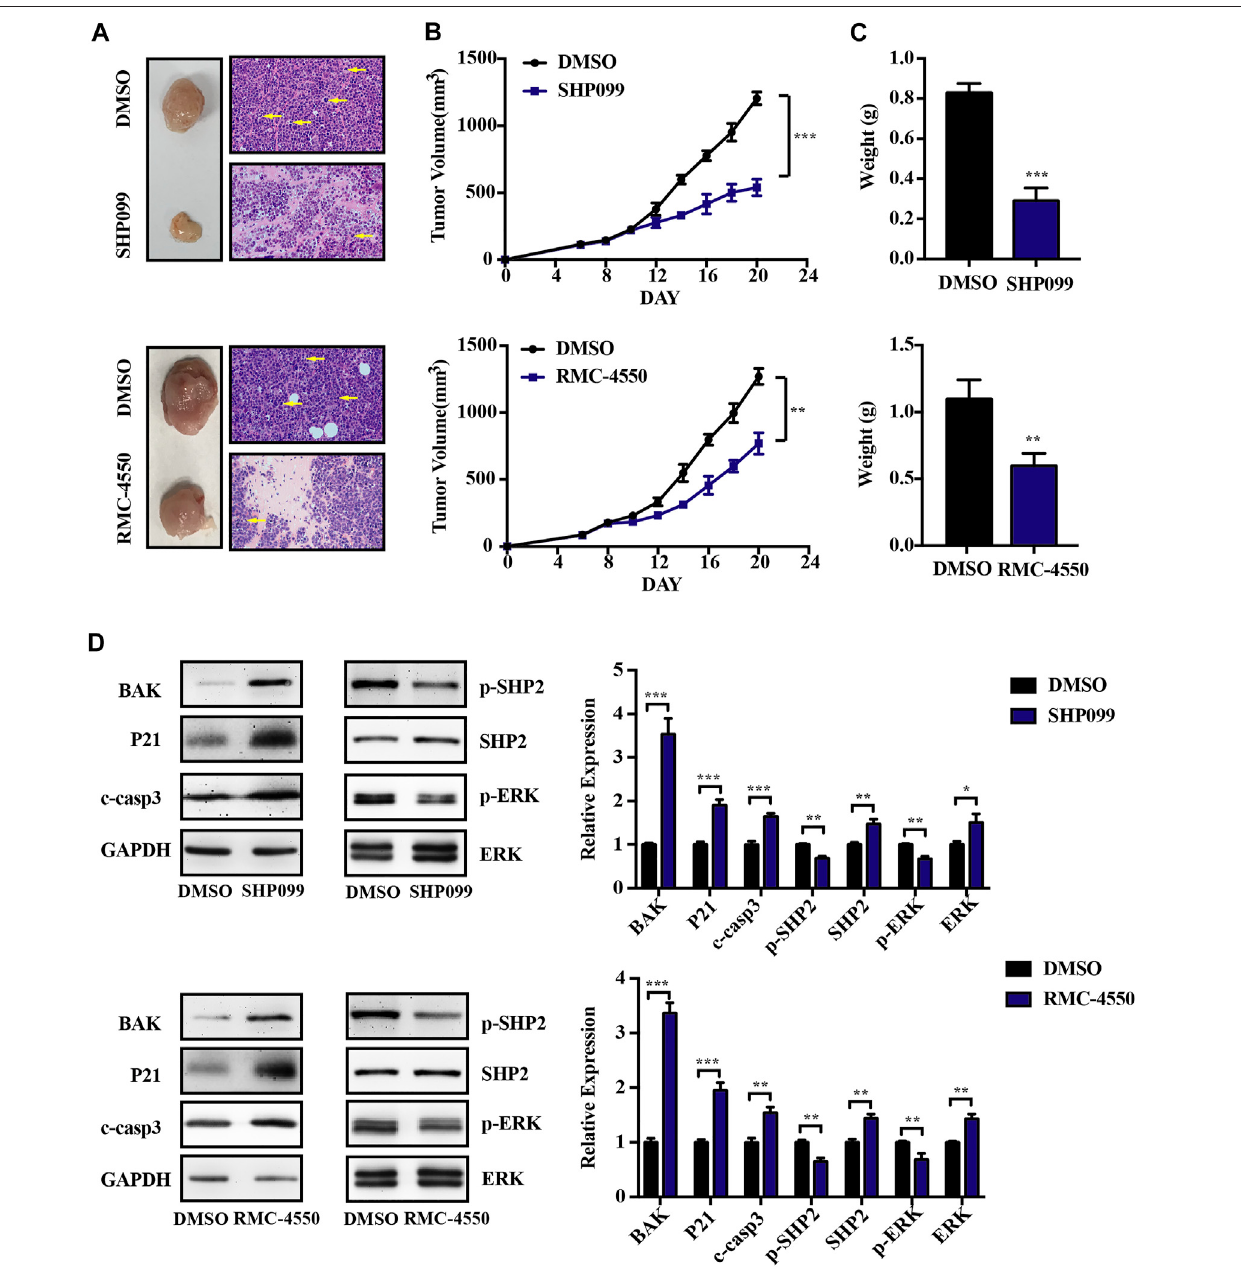
FIGURE 5 | SHP2 inhibitors show antitumor effects in vivo by using MM xenograft mouse models. (A) Representative images of tumors isolated from mice after approximately 2 weeks of treatment with SHP2 inhibitors (SHP099 or RMC-4550) or vehicle and H&E staining of tumor sections were shown. The pathological mitosis was marked with yellow arrows. (B) Tumor volume was measured every 2 days, and tumor growth rates were signi fi cantly reduced in SHP2 inhibitor – treated mice. (C) Tumor weight was measured and compared at the last day of the experiment (mean ± SD). (D) Expression of BAK, P21, cleaved caspase-3, p-SHP2, SHP2, p-ERK,andERKindifferentgroupswasmeasuredbyWesternblottingandwasthenquanti fi edbyImageJsoftware;GAPDHwasusedasaloadingcontrol.Datashown are mean ± SD. ** p < 0.01 and *** p < 0.001.